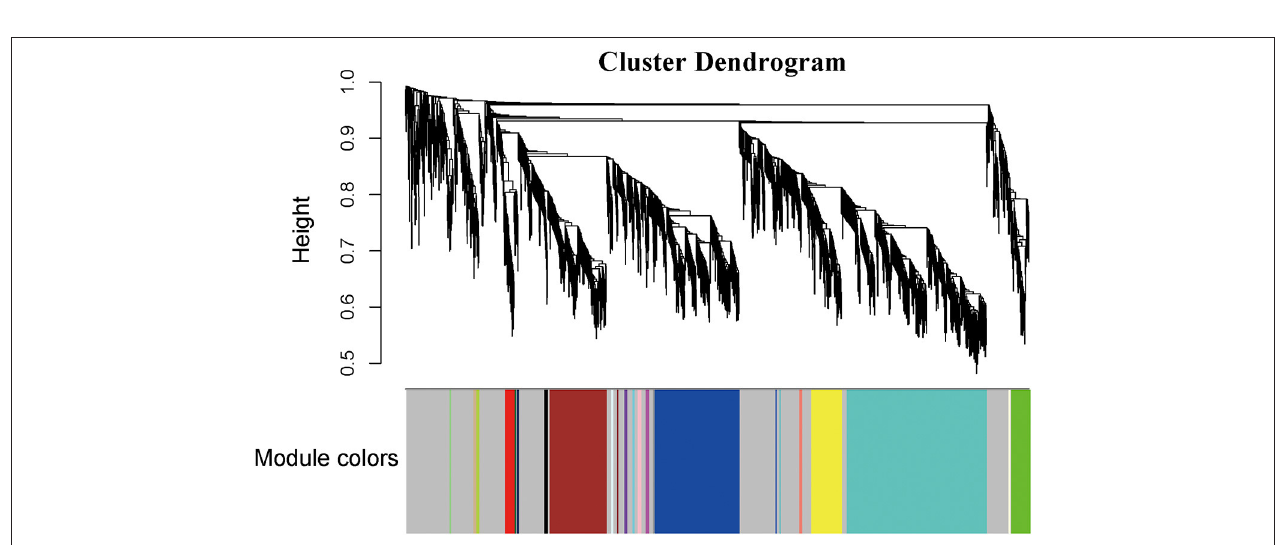
FIGURE 2 | Construction of coexpression modules by the WGCNA package in R. The cluster dendrogram of genes in GSE143765. Branches of the cluster dendrogram of the most connected genes gave rise to 23 gene coexpression modules.Genes that could not be clustered into one of these modules were assigned to the gray module. Every gene represents a line in the hierarchical cluster. The distance between two genes is shown as the height on the y -axis.